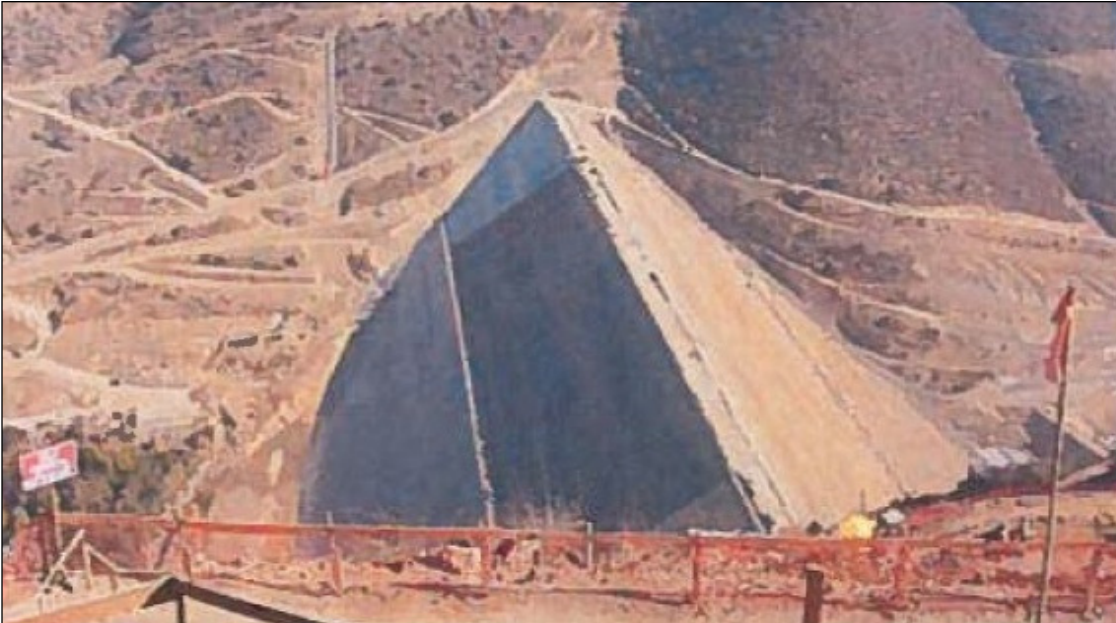
Figure 17. Starter dam upstream face geotextile–geomembrane liner installation second stage finished—TSF Starter Dam, Chile [42,43].